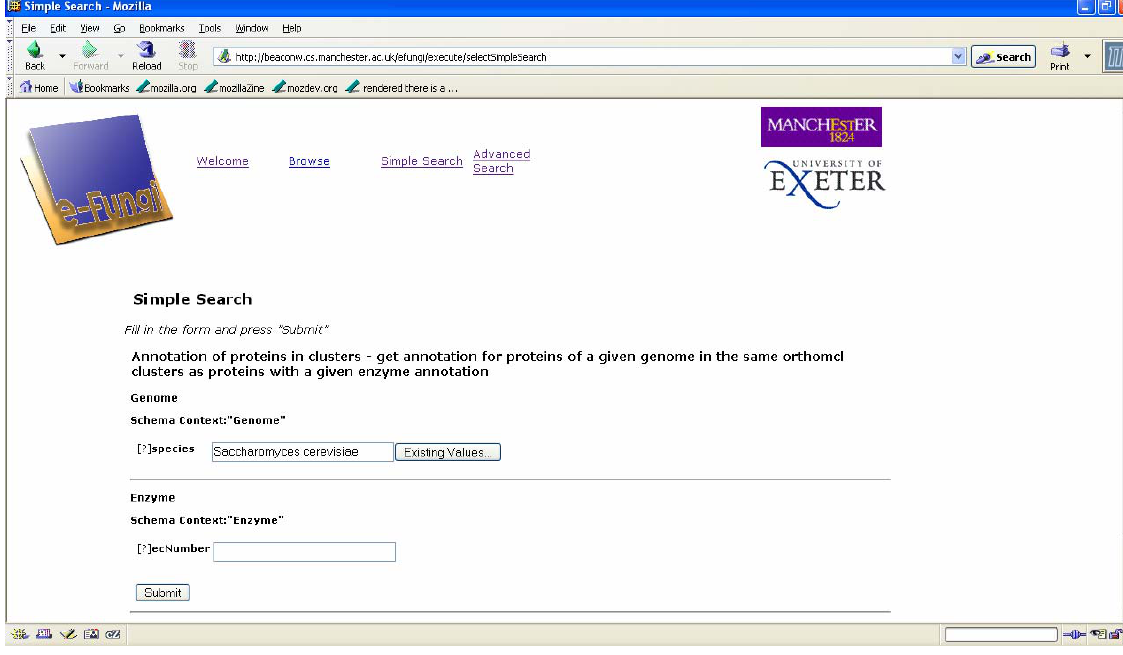
Figure 8: Providing parameters for a canned query in